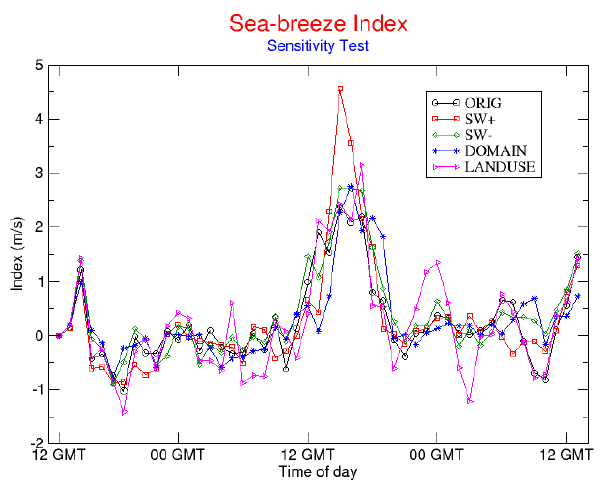
Fig. 12. Lake breeze index (see text) calculated for the original run (ORIG) and all the sensitivity experiments of the SUMWF case.